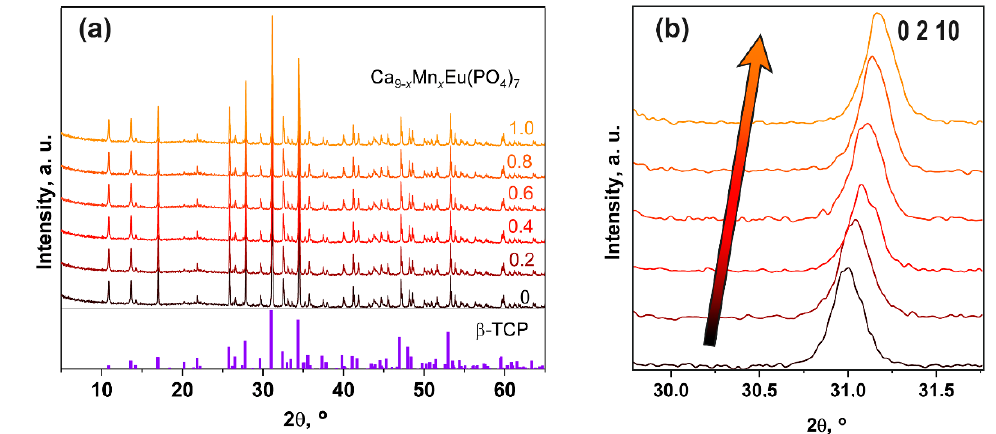
Figure 6. PXRD patterns of Ca 9 − x Mn x Eu(PO 4 ) 7 and the positions of Bragg reflections of β -TCP ( β -Ca 3 (PO 4 ) 2 , PDF#4 Card No. 00-09-0169) ( a ); The enlarged main reflection (0 2 10) of Ca 9 − x Mn x Eu(PO 4 ) 7 solid solution ( b ).